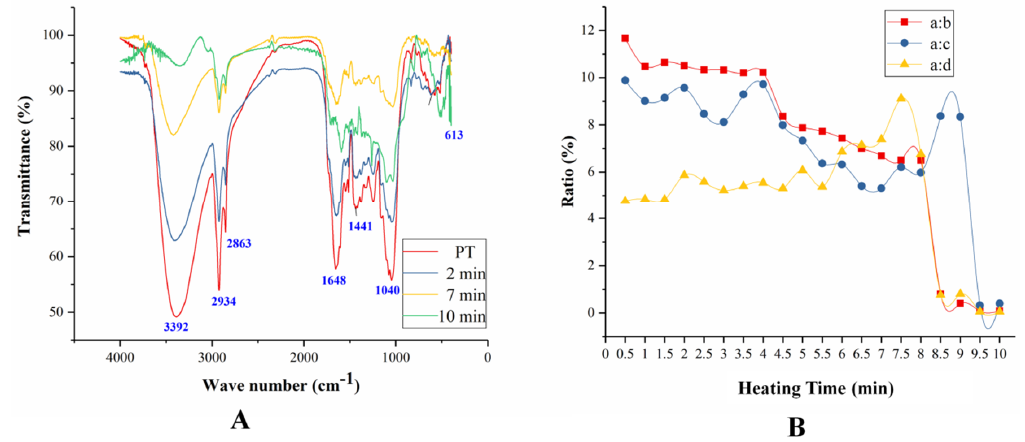
Figure 3. The FTIR of PT samples during the frying processes ( A ) and the ratio of band a to band b, c, and d ( B ).